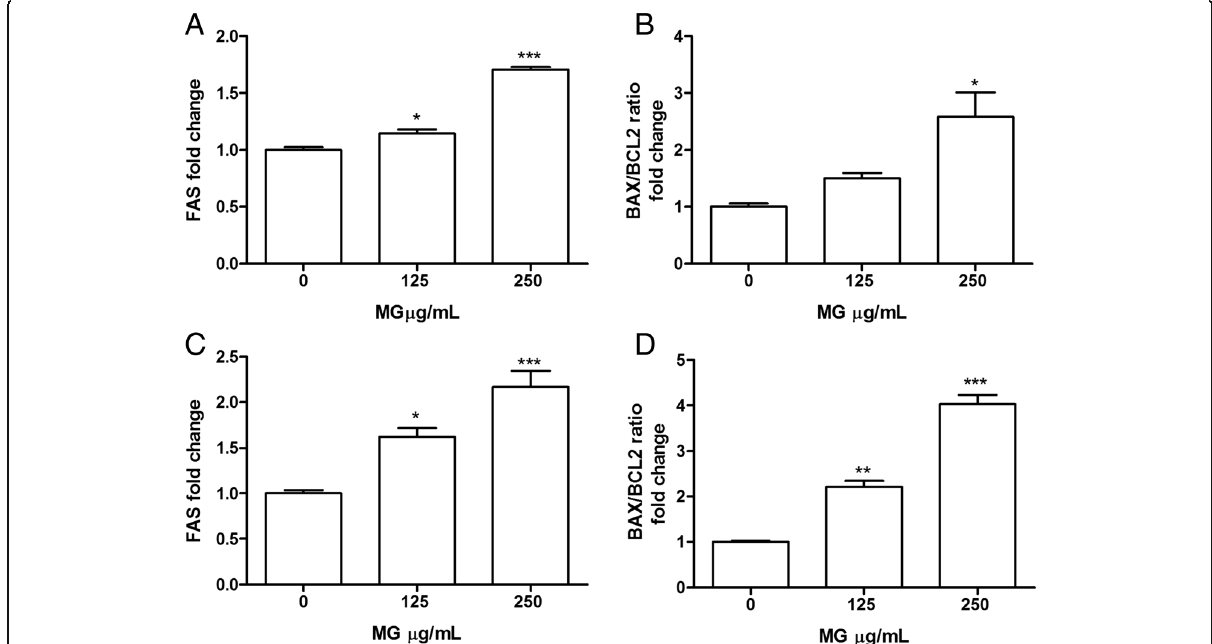
Fig. 7 Effect of MG extract treatment on FAS, BAX and BCL2 expression level in Jurkat ( a , b ) and HL-60 ( c , d ) cells. Total RNA was isolated, and the mRNA level of target genes was quantified using RT-PCR normalized to 18S rRNA and GAPDH as reference genes. Triplicate reactions were performed for each experiment. Each bar represents the mean ± SEM of three independent experiments. Data were analysed by one-way ANOVA followed by Bonferroni ’ s test. * p < 0.05 vs control; ** p < 0.01 vs control; *** p < 0.001 vs control